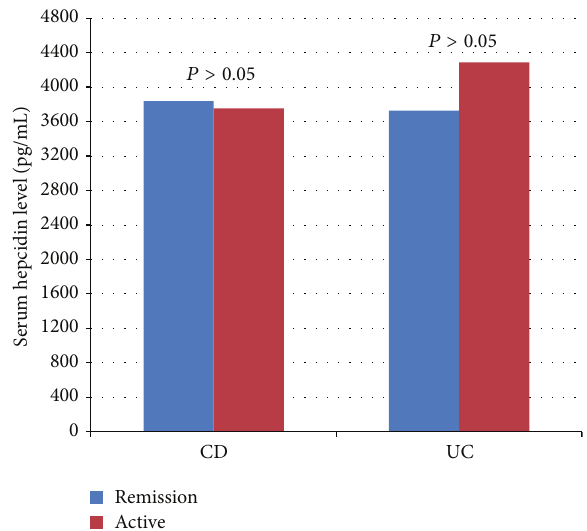
Figure 1: Hepcidin levels in IBD patients in remission and the active phase